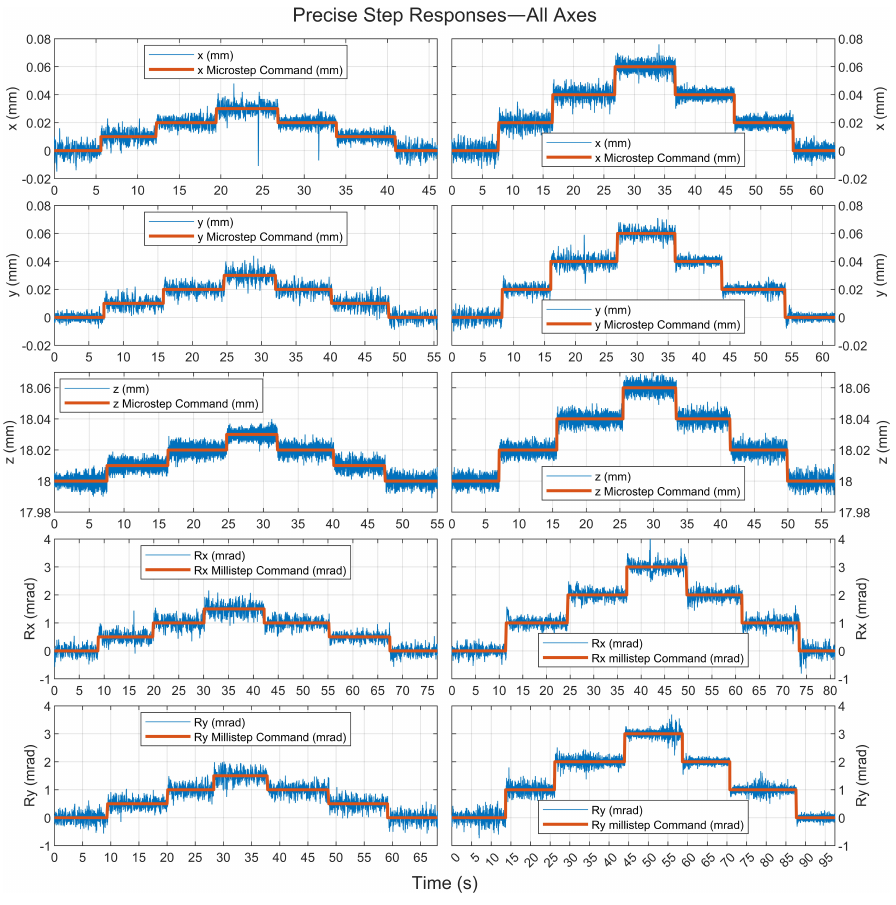
Figure 14. All axes precise step responses.